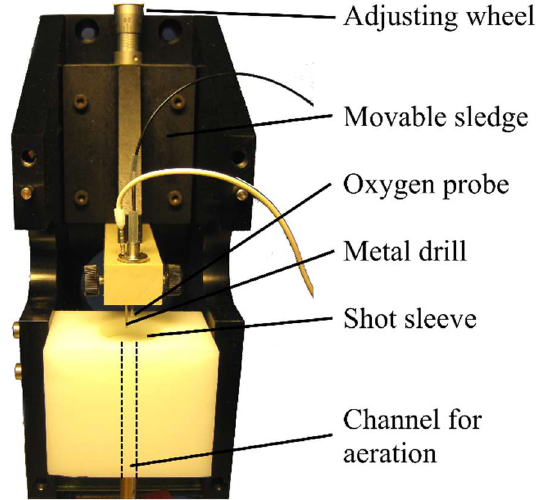
Figure A1. Micromanipulator device to measure the oxygen saturation in different hydrogel-depths. The oxygen probe was fixated in a movable sledge which was moved in defined 50 µm distances by an adjusting wheel. The hydrogel containing the bacterial cells was casted in a shot sleeve, under which a channel for aeration with oxygen was located. After the gel was casted, molecular oxygen was introduced through the channel and the resulting oxygen penetration depth was recorded with the oxygen probe OXY1-ST-pST7.